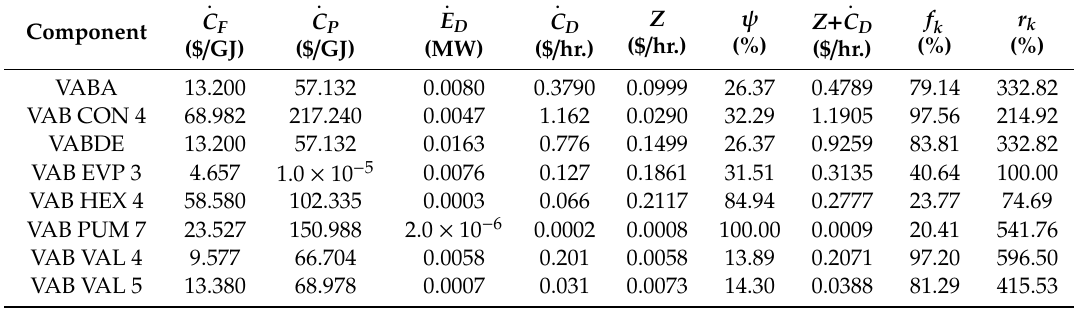
Table 11. Summary of the exergoeconomic parameters for the vapor absorption system (VAB).